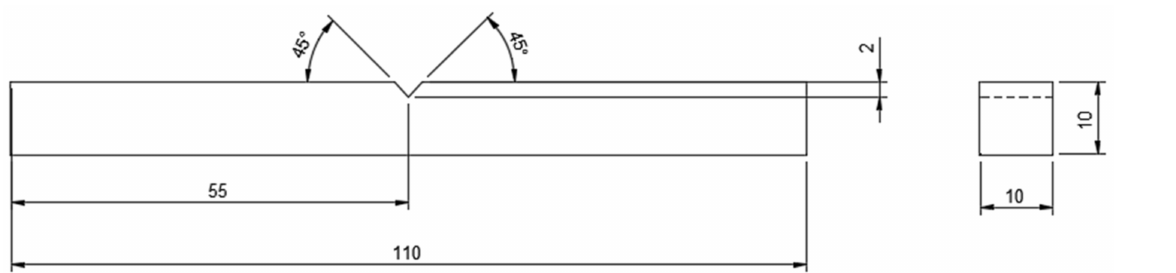
Figure 9. ASTM D6110 specimen for impact